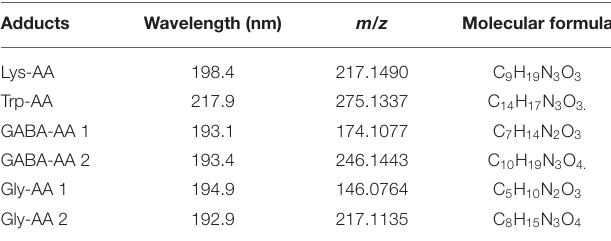
TABLE 3 | Wavelength, m/z, and molecular formula of